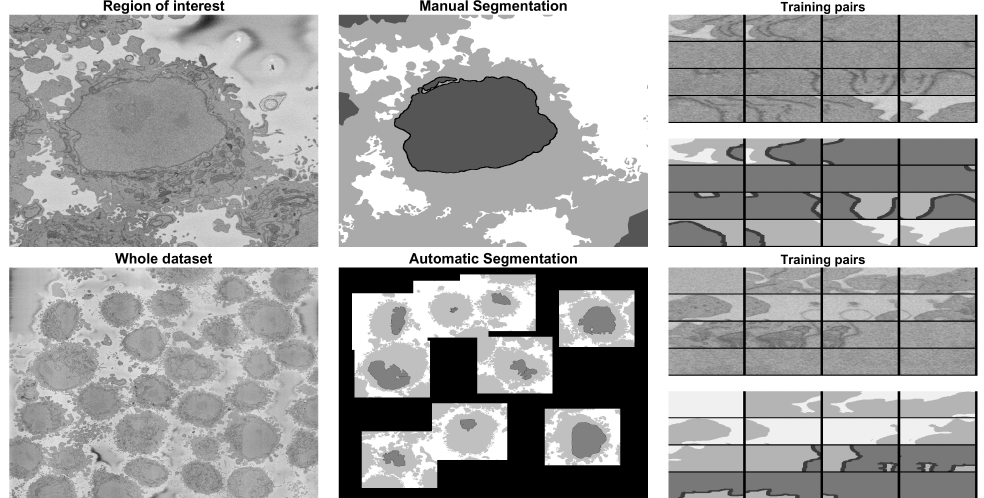
Figure 6. Illustration of different approaches to generate training data. The first approach shown in the top row required the manual segmentation of a 2000 × 2000 × 300 region of interest. The region was manually cropped, and then each slice was manually segmented. The image and the ground truth were used to generate pairs of patches of data and labels used in strategies 1, 2 and 3. The second approach illustrated in the bottom row applied an image processing algorithm without manual intervention. A series of cells were detected in an image. Then, in a sequential manner, each of these was automatically cropped and segmented, and the image and ground truth were used to generate pairs of patches of data and labels used in strategy 4. The number of pairs is described in Section